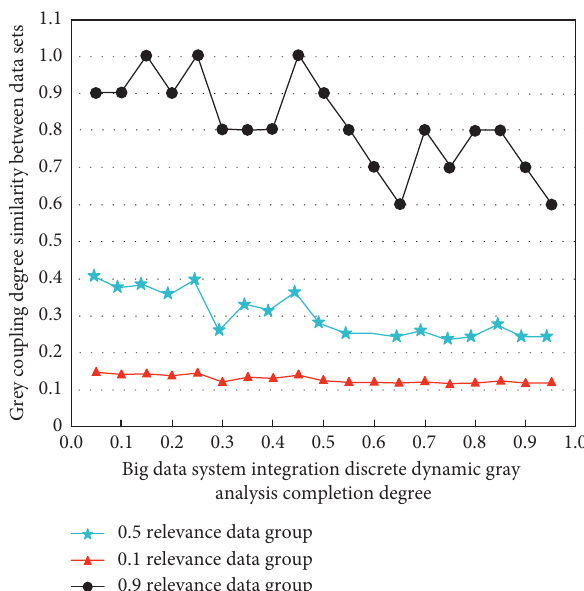
Figure 4: Simulation results of the completion and similarity of the discrete dynamic grey analysis of the big data system